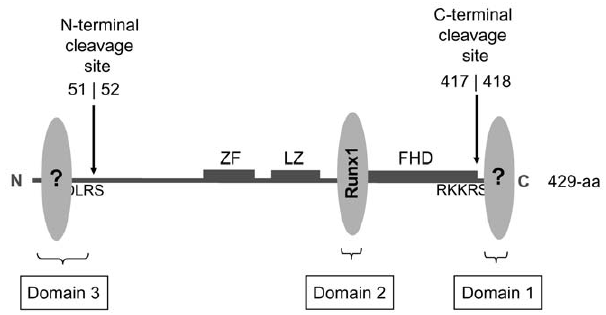
Figure 7. Domains 1, 2 and 3 of Foxp3. Schematic diagram showing the locations of the N-terminal and C-terminal cleavage sites (between residues 51 and 52, and 417 and 418). The approximate locations of Domains 1, 2 and 3 that contribute to nuclear transport of Foxp3 are indicated. Grey oval structures designate factors that bind to these three domains and help nuclear translocation of Foxp3.